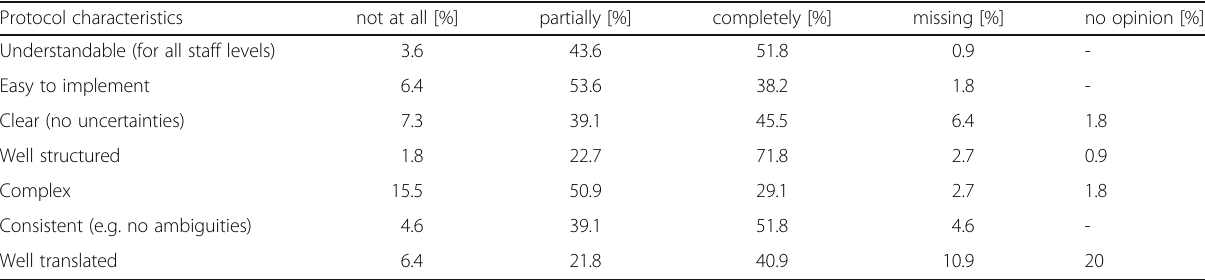
Table 5 Protocol characteristics Protocol